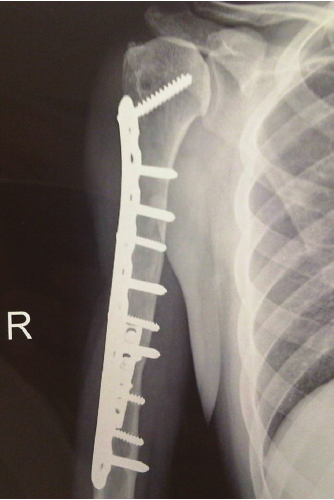
Figure 3: Anteroposterior radiograph of an APC of the elbow after resection of the proximal ulna.